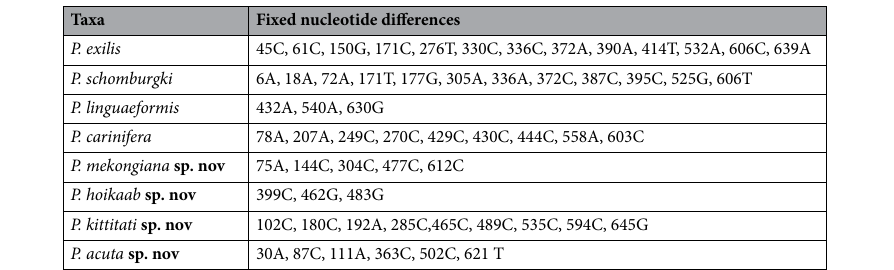
Table 2. Fixed nucleotide differences of COI sequences among Pilsbryoconcha species. Nucleotide position based on the sequence alignment in this study.